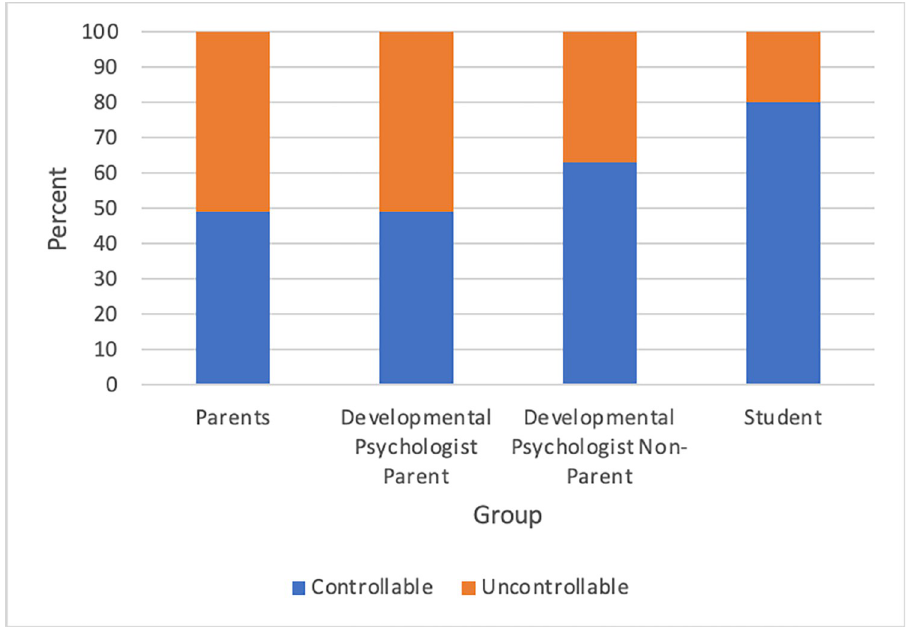
Fig 3. Participants’ perceived controllability by